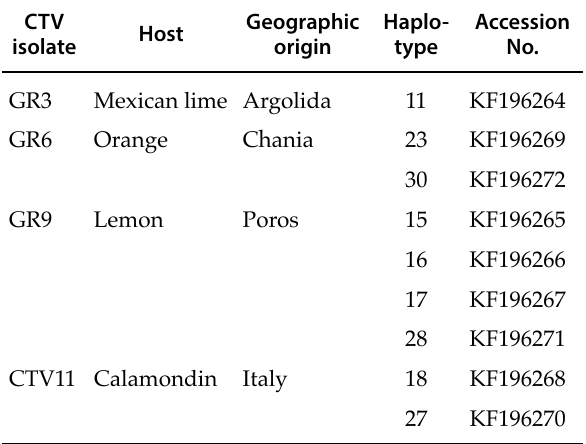
Table 1. The GeneBank accession numbers and geographi - cal locations in Greece and Italy of nine isolates and vari- ants of Citrus tristeza virus (CTV).